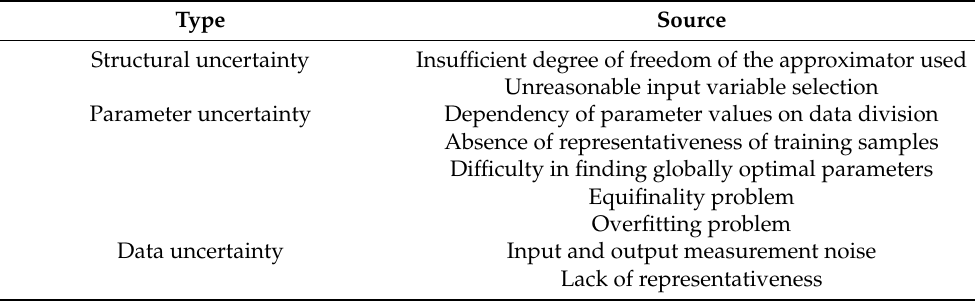
Table 2. Sources of uncertainties in data-driven modeling and prediction. Type Structural